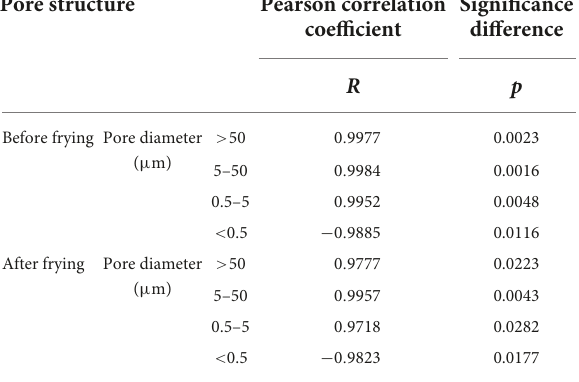
TABLE 3 Numerical values of Pearson’s correlation coefficients between oil contents and pore structure. Pore structure Pearson correlation